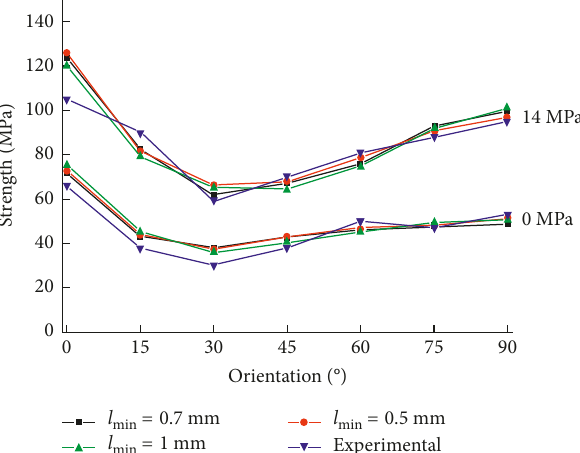
30 ° ; (c) α 15 ° ; (d) α 90 ° ; (e) α 75 ° ; (f) α 60 ° . 45 ° ; (b) α (cid:29) (cid:29) (cid:29) (cid:29) (cid:29) (cid:29)